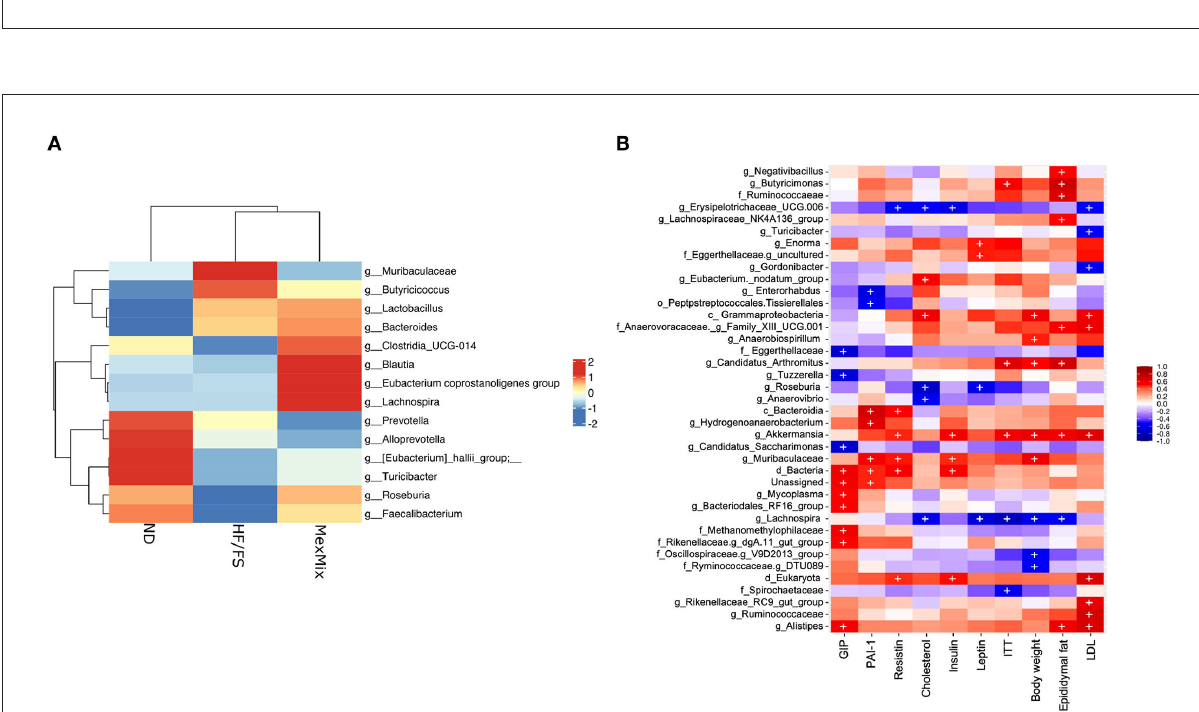
FIGURE5 Effect of MexMix in microbiota diversity. (A) Alpha diversity: observed ASVs, Chao1, Shannon, and Simpson indexes. (B) Beta diversity and three-dimensional scatter plot generated using principal coordinate analysis (PCoA). (C) Relative abundance of bacterial phyla. Data represent mean ± SEM.